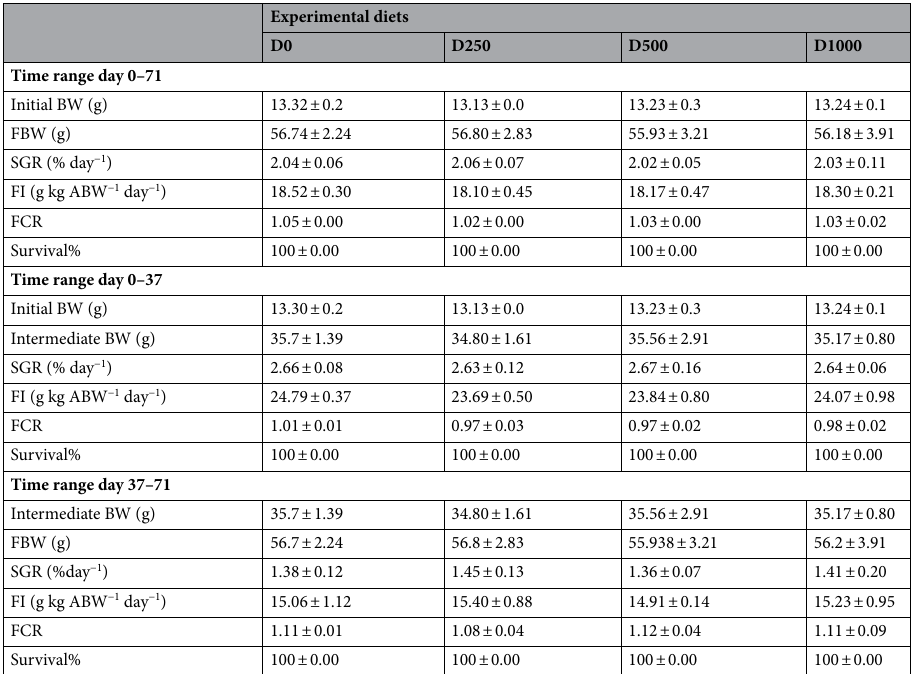
Table 1. Growth performance of European sea bass juveniles fed the experimental diets D0, D250, D500, D1000 calculated over 71 days (time range day 0–71) and at intermediate periods (time range day 0–37 and 37–71). Data are given as the mean (n = 3) ± SD. No significant differences were detected ( P > 0.05). D dose blend (citric acid 25%, sorbic acid 16.7%, thymol 1.7%, vanillin 1%, matrix of hydrogenated fats) inclusion in diet, D0 0 ppm, D250 250 ppm, D500 500 ppm, D1000 1000 ppm, Initial BW initial body weight, Intermediate BW intermediate body weight, FBW final body weight, SGR specific growth rate